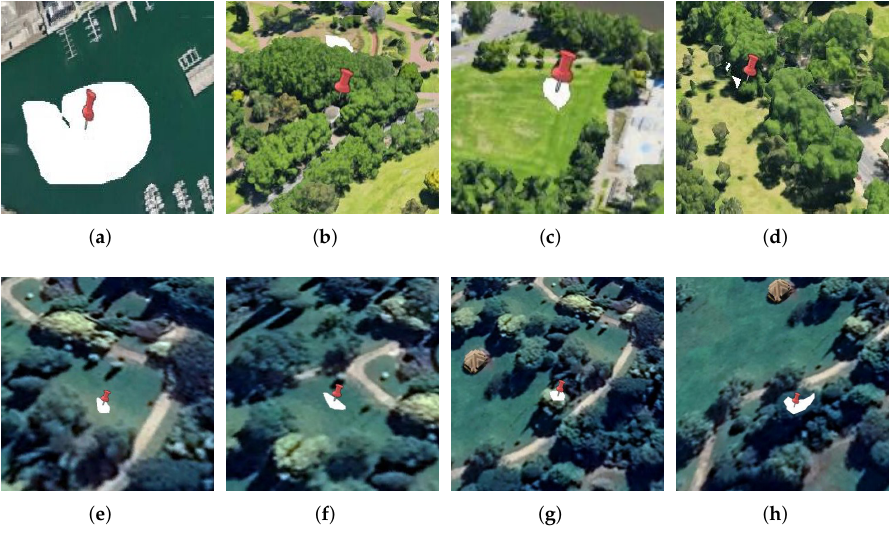
Figure 7. Polygons with place markers (( a ) Non-vegetation; ( b ) Vegetation; ( c ) Shrub; ( d ) Trees; ( e ) Stressed shrub; ( f ) Healthy shrub; ( g ) Stressed trees and ( h ) Healthy trees) that are plotted using Google Earth Engine (GEE) [2] in different regions of City of Melbourne, Victoria, Australia. In our paper, shrub represents grasslands and bushes, whereas trees represent the vegetation except